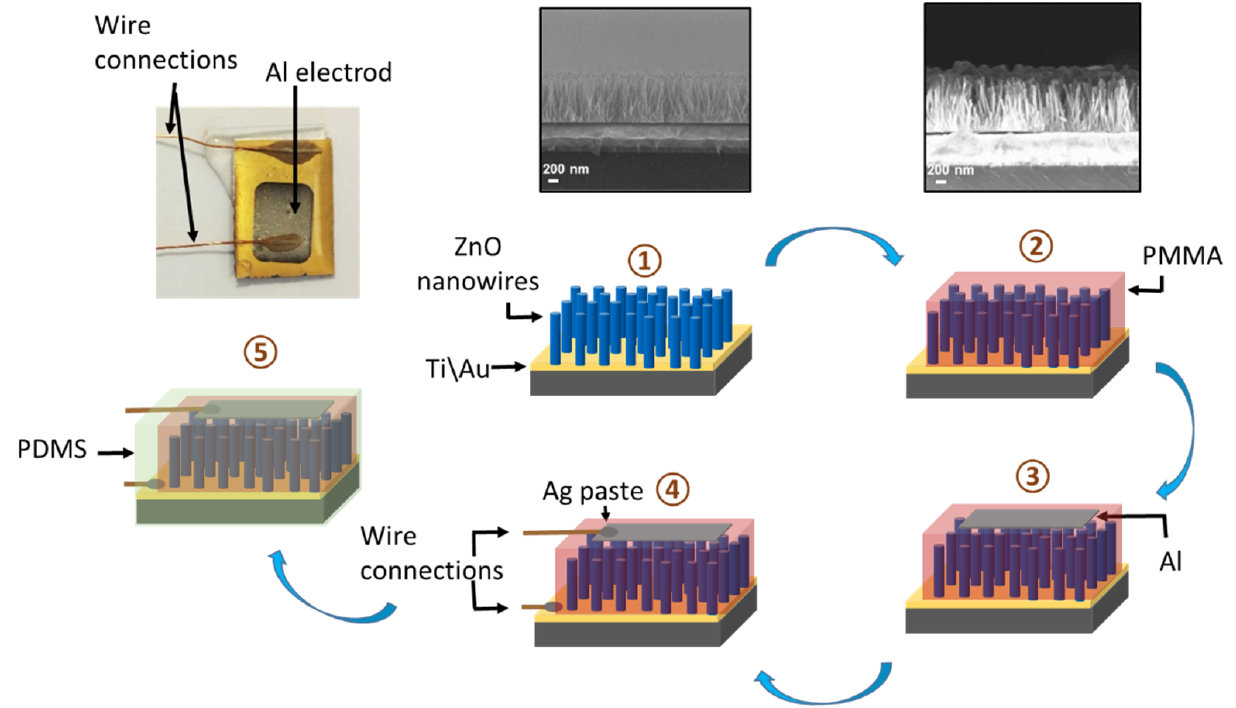
Figure 3. Schematic showing the device and reference sample assembly, along with a photograph of a completed device.